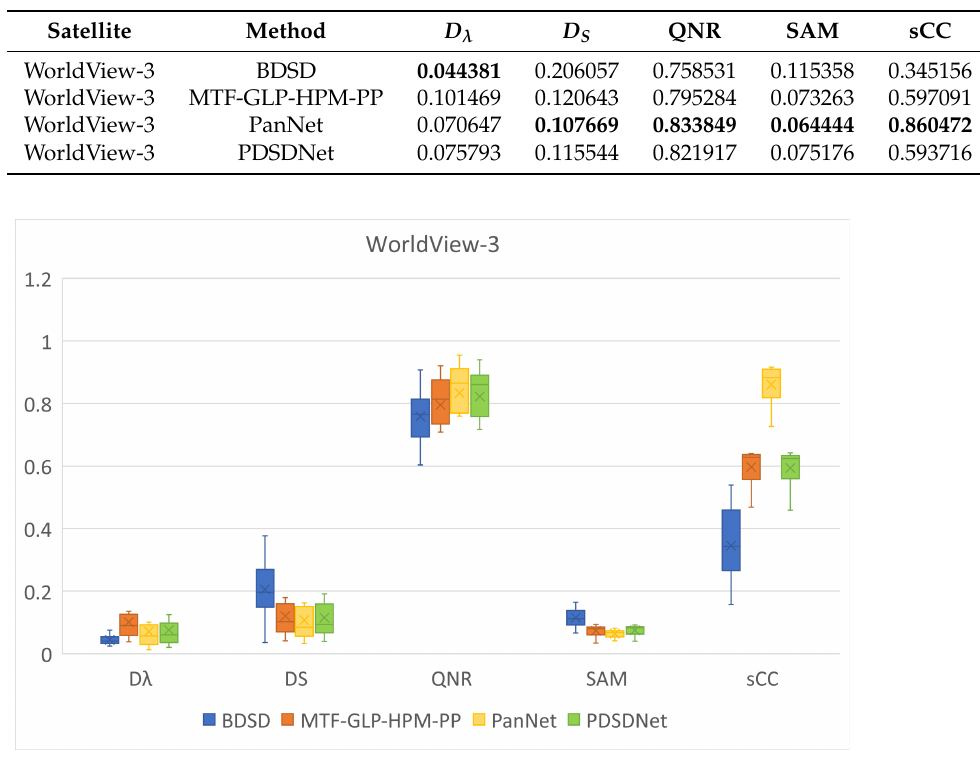
Figure 12. Quality indexes of results of BDSD, MTF-GLP-HPM-PP, PanNet, and PDSDNet. For only six bands participating in learning the simulated PAN in PDSDNet, but with the details being added to all bands, we select the eighth, third, and first band for false color composite (FCC) to observe the effect in Figure 13. The eighth band and the first band were not involved in simulating PAN. The details are shown in Figure 14, and the first row from left to right is PAN, FCC of MS, and FCC of PDSDNet result, then the second